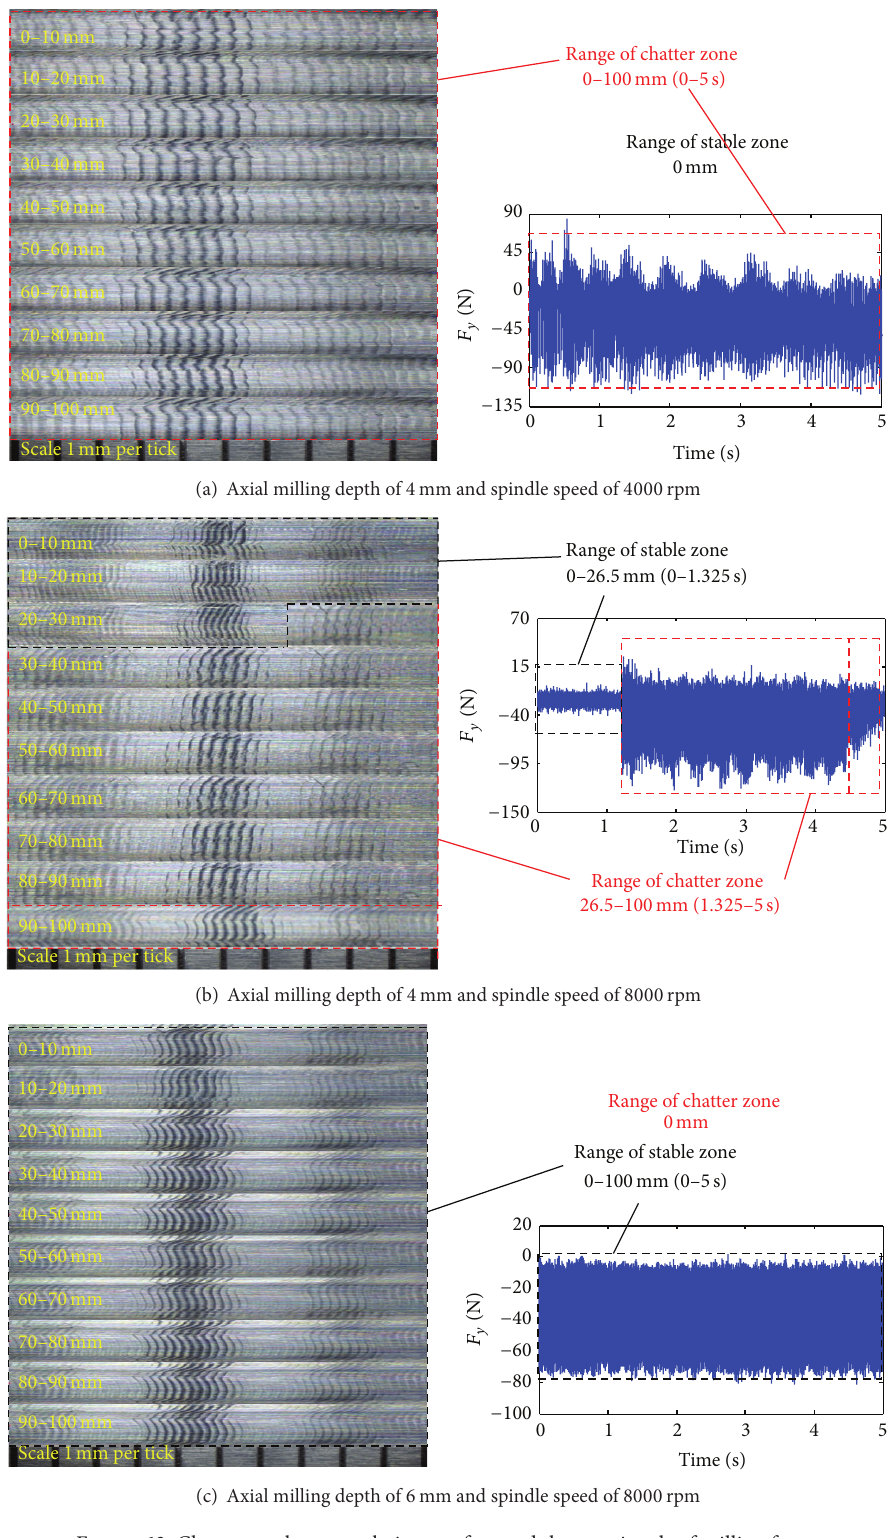
Figure 12: Chatter marks on workpiece surface and the test signals of milling